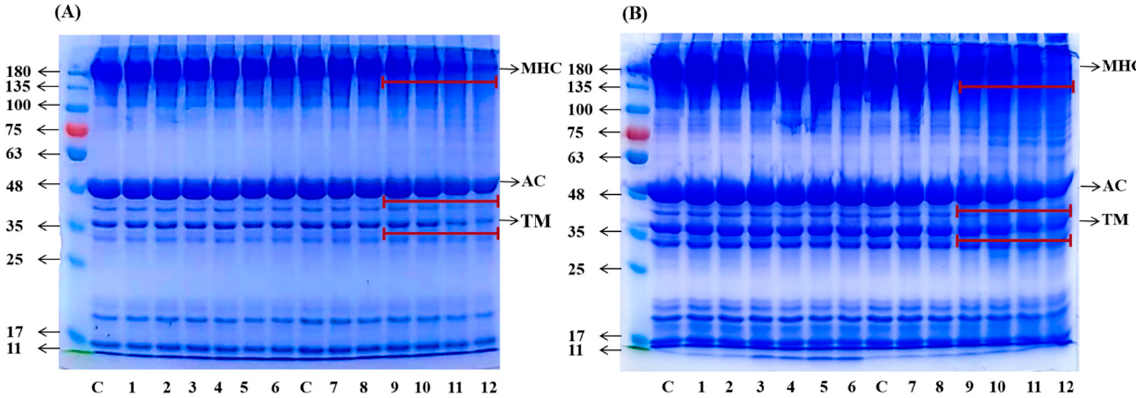
Figure 5. Sodium dodecyl sulfate–polyacrylamide gel electrophoresis profiles of myofibrillar protein (MP) ( A ) and myofibrillar protein and glucose (MPG) ( B ) under different heating conditions (80 ◦ C and 98 ◦ C, 0–45 min). Lanes: c = 0 min; 1 = 80 ◦ C, 2.5 min; 2 = 80 ◦ C, 5 min; 3 = 80 ◦ C, 10 min; 4 = 80 ◦ C, 15 min; 5 = 80 ◦ C, 30 min; 6 = 80 ◦ C, 45 min; 7 = 98 ◦ C, 2.5 min; 8 = 98 ◦ C, 5 min; 9 = 98 ◦ C, 10 min; 10 = 98 ◦ C, 15 min; 11 = 98 ◦ C, 30 min; 12 = 98 ◦ C, 45 min; MHC: myosin heavy chain; AC: actin chain; TM: tropomyosin chain.